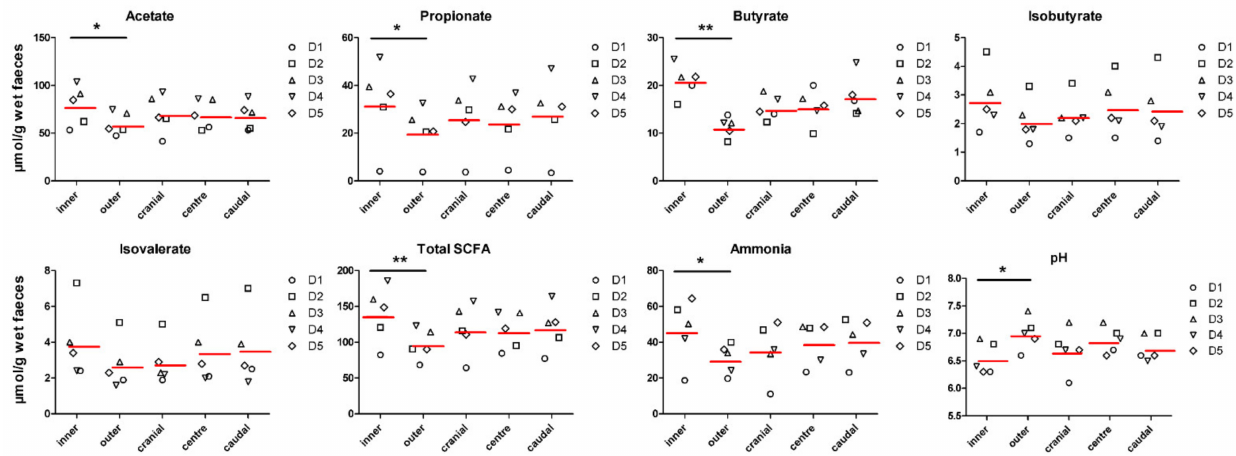
Figure 1. Short-chain fatty acids and ammonia concentrations, and pH values in stool subsamples collected from five different dogs. Concentrations of metabolites are expressed as µ mol per gram of wet faeces. Red lines represent the mean of faecal SCFA and ammonia concentrations, and pH values. * p < 0.01 and ** p < 0.001. Dn = dog ID.